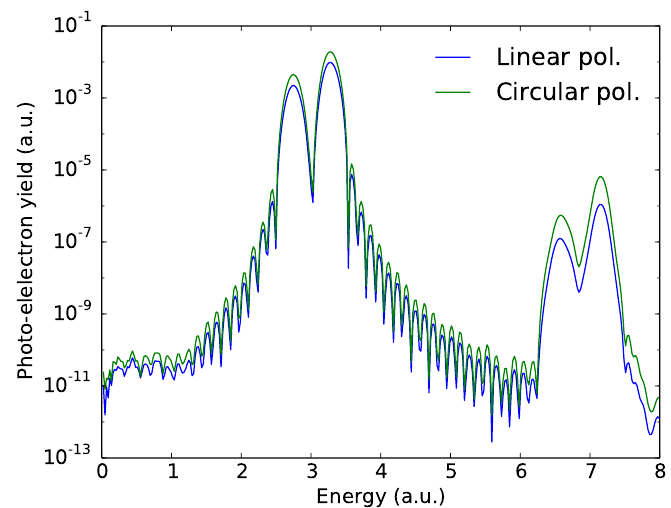
Figure 4. Total photo-electron spectra from Argon with linearly and circulary polarized 15 cycle, 12 nm wavelength, cos 2 envelope laser pulses with a peak intensity of 9 × 10 13 W/cm 2 .